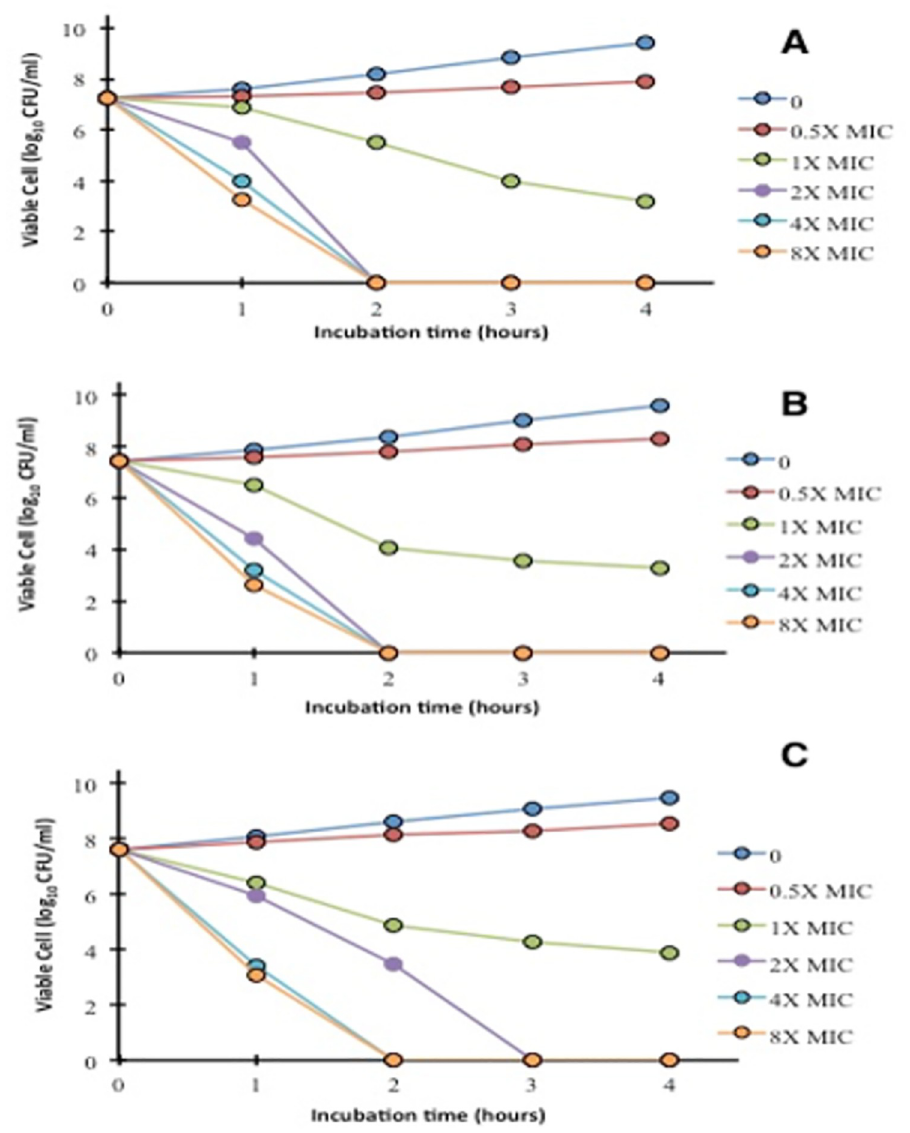
Fig 4. Time kill kinetics of antibiotic-resistant foodborne pathogens (A) S . aureus (B) S . enterica (C) E . coli , after treatment with different concentrations of green synthesized zinc oxide nanoparticles. formation after treatment of cells with sub-inhibitory concentrations of green synthesized ZnO NPs. After 24 hours of incubation, maximum biofilm formation in untreated cells was observed for E . coli , whereas the minimum number of adhered cells was found for S . aureus .